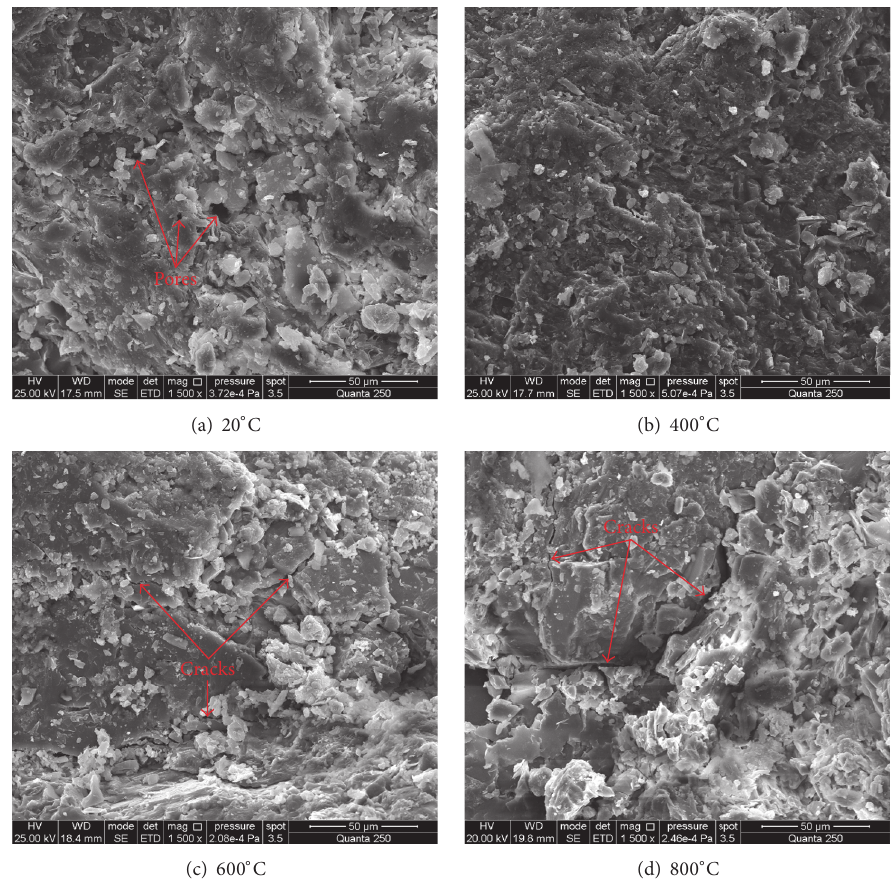
Figure 2: SEM observations of sandstone after different high-temperature treatments.